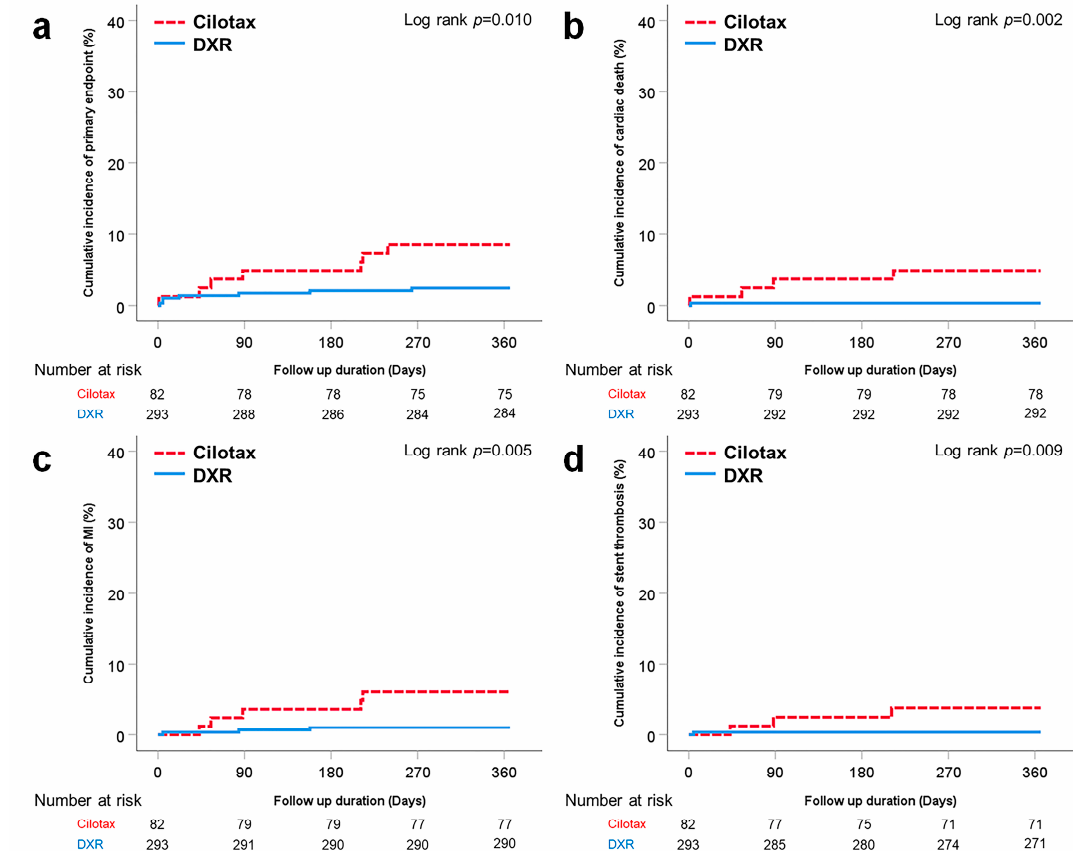
Figure 2. Kaplan–Meier graphs of the cumulative incidence of target lesion failure ( a ) and its individual components— cardiac death ( b ), myocardial infarction ( c ), and stent thrombosis ( d